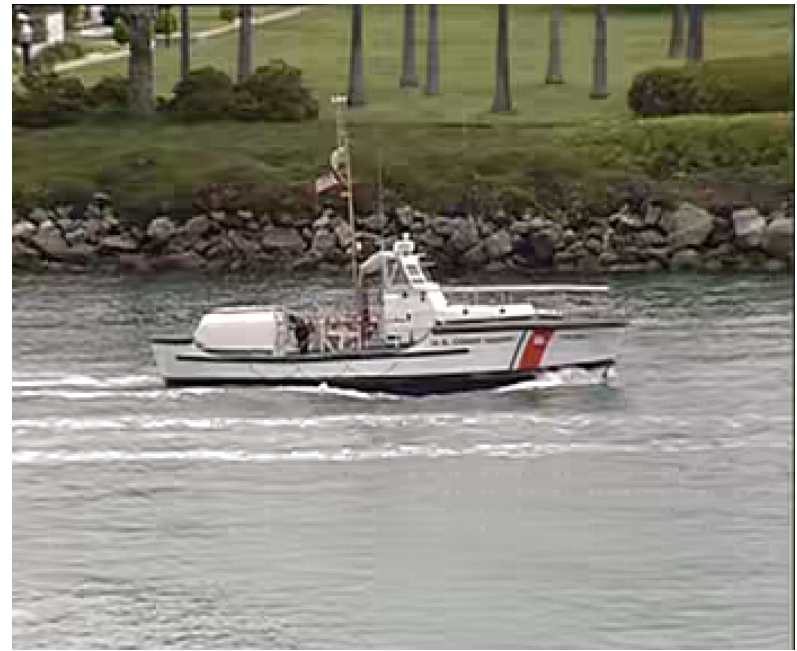
Figure 16. Frame of output video from dual